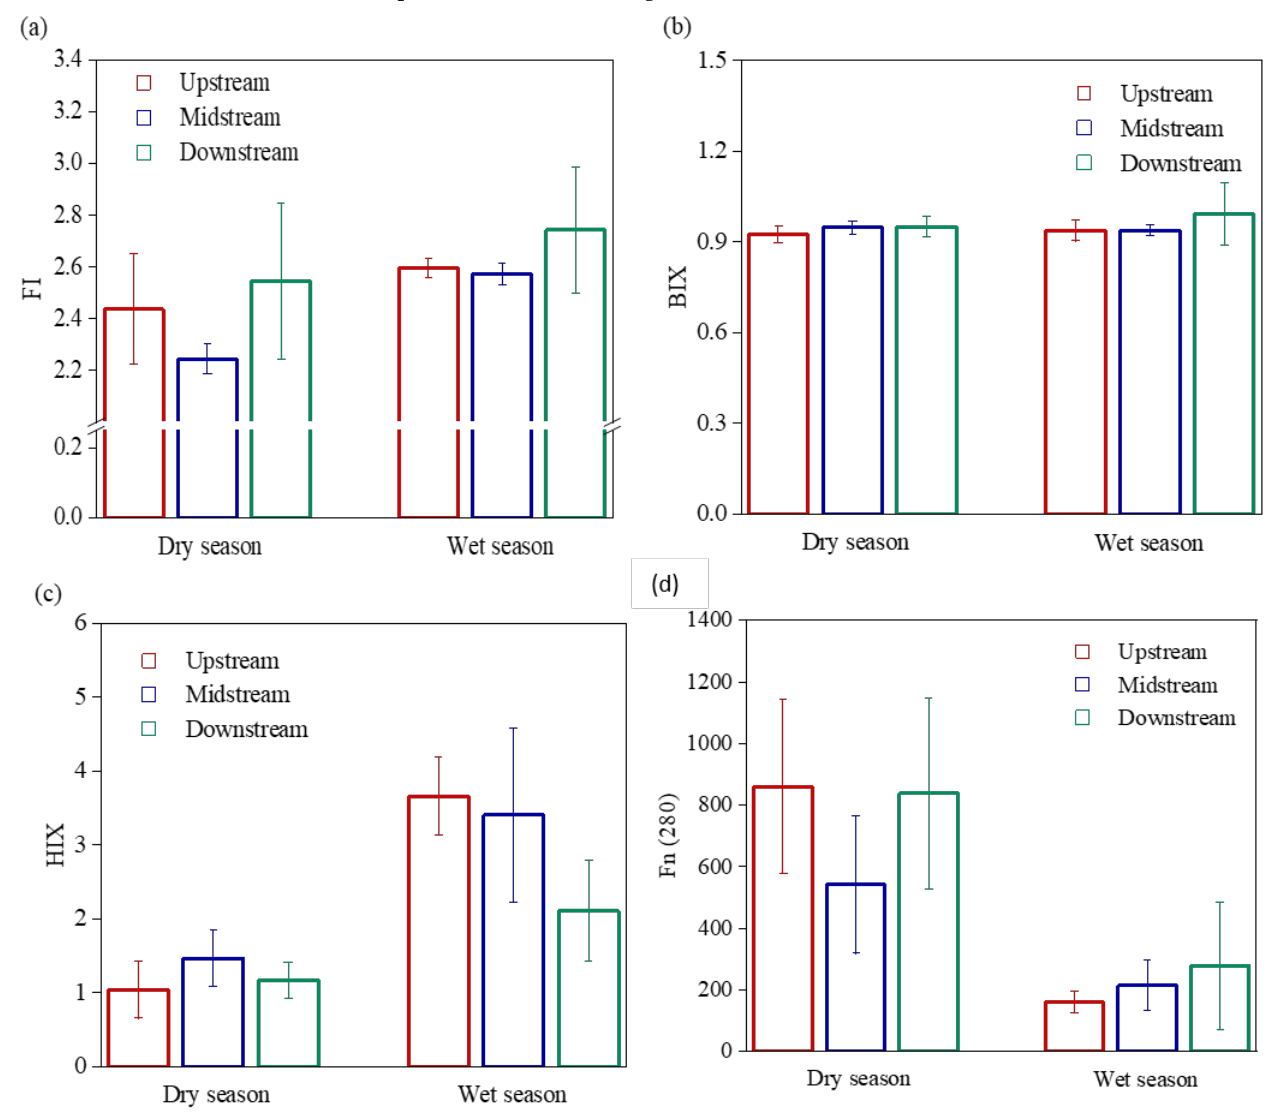
Figure 4. Fluorescence spectral parameters of DOM in the Wanggang River. ( a ) FI; ( b ) BIX; ( c ) HIX; ( d )